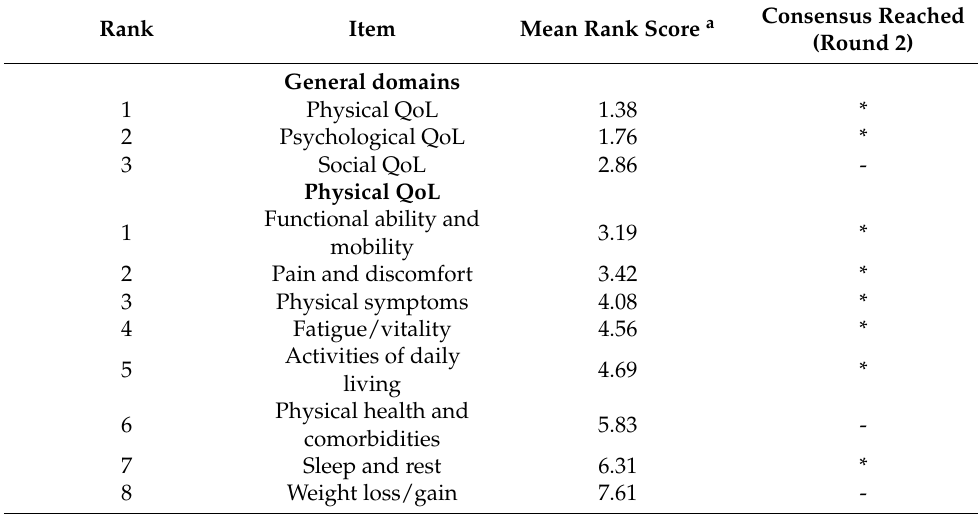
Table 3. Mean ranking of the QoL